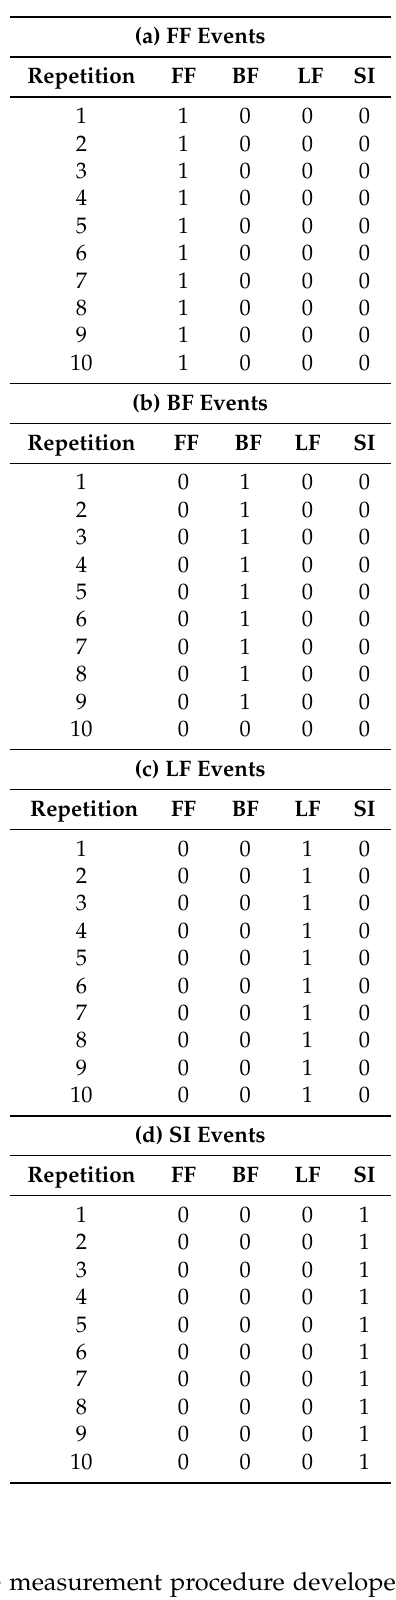
Table 5. Examples of classification performance for the ATA